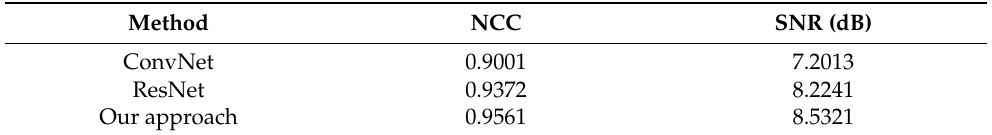
Table 6. Quantitative evaluation of the MT data denoised by different methods (added simulation noise).